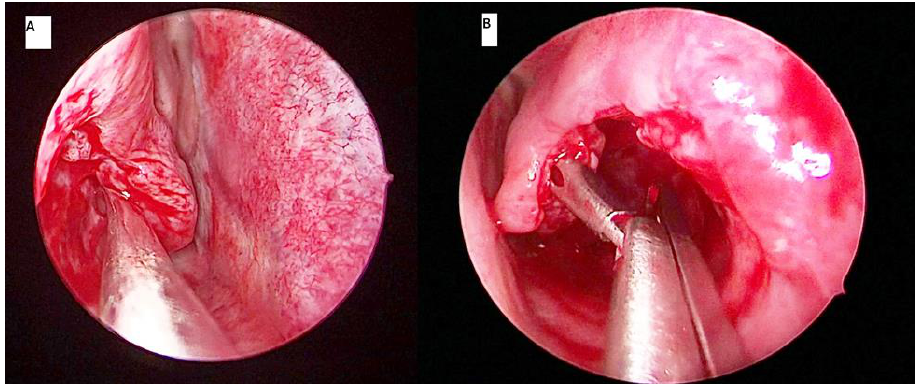
Figure 2. In conventional turbinoplasty, a freer elevator dissects the turbinate bone and soft erec- tile tissue ( A ) and a Blakeley’s forceps later removes part of the soft tissue and bone ( B